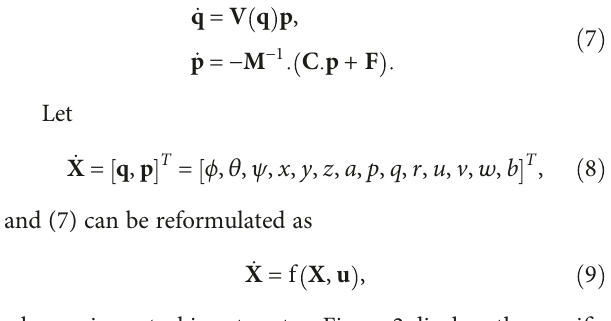
Figure 4: Lyapunov exponents spectrum of the MUAV ( a